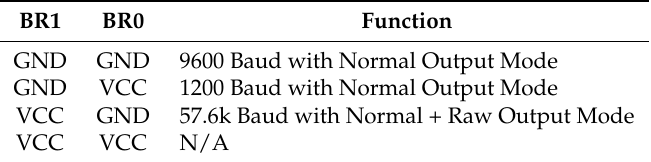
Figure 4. Configuration pads in TGAM1 chip. ( a ) Main pads. ( b ) B0 and B1 pads. ( c ) M pad. Table 3. Configuration pads.